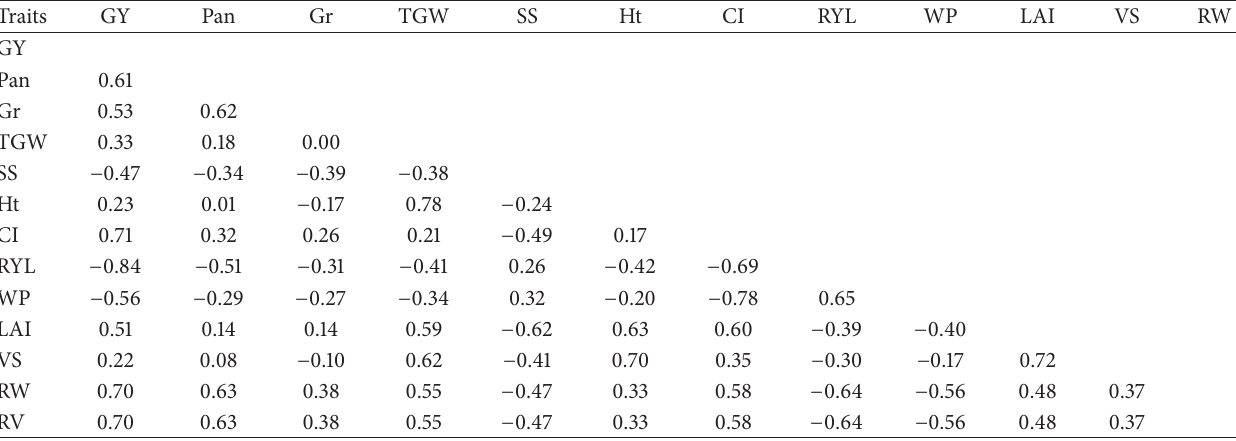
Table 5: Correlation among different traits in partial weedy conditions. The critical value of 𝑟 was 0.40 at 5% level of significance. Traits GY